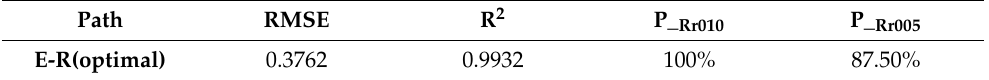
Table 6. Evaluation metrics of the multi-path combination after